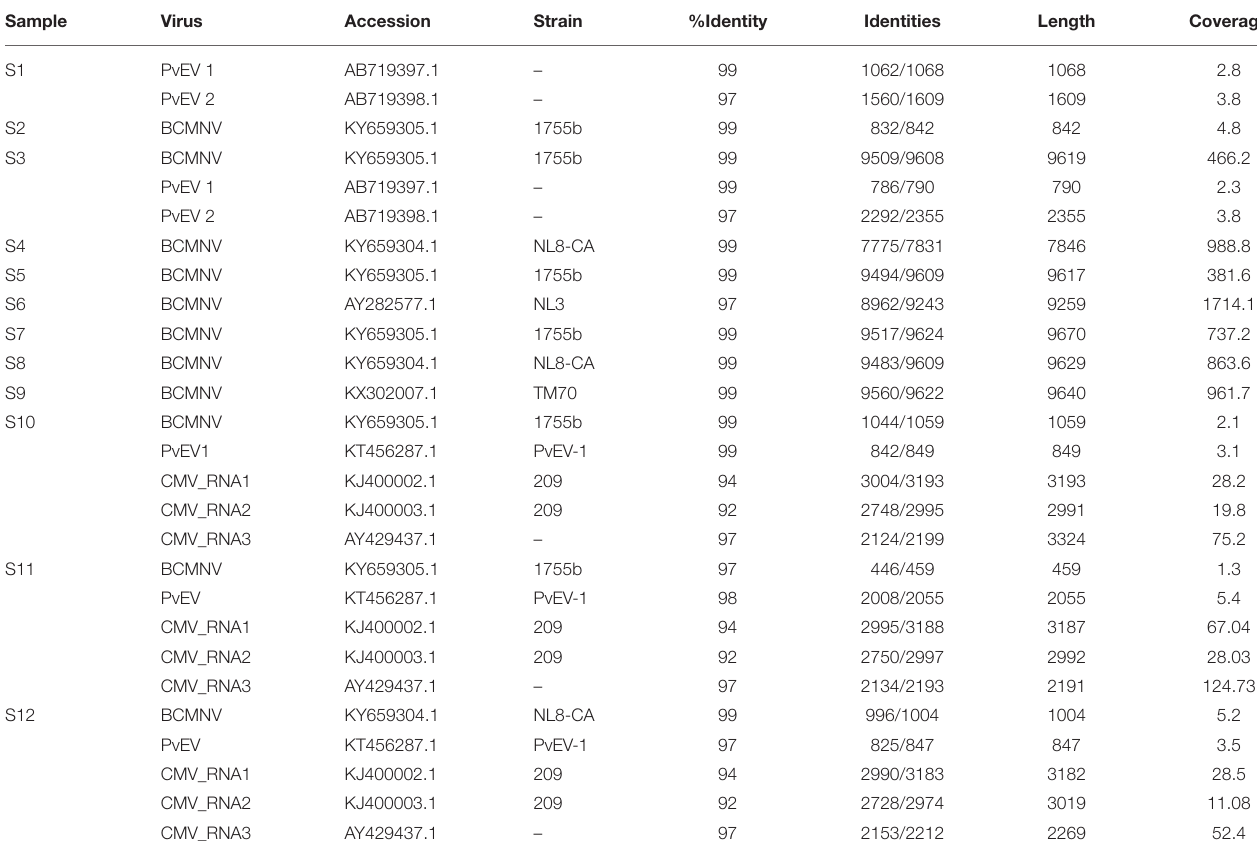
TABLE 3 | Virus sequences identified in each sample and identity with database sequences.